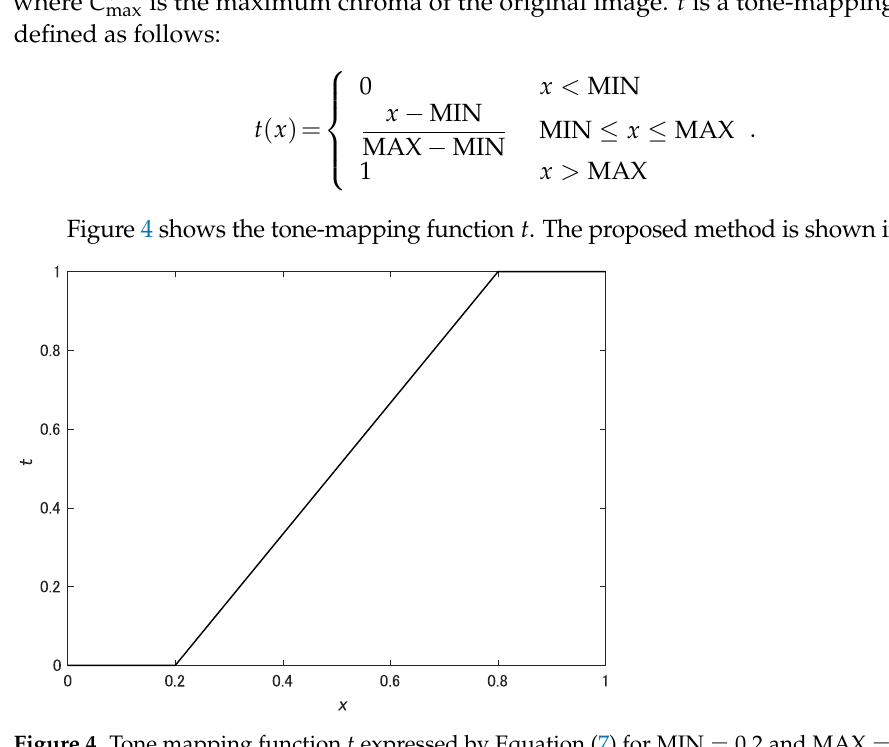
Figure 4. Tone mapping function t expressed by Equation (7) for MIN = 0.2 and MAX = 0.8.